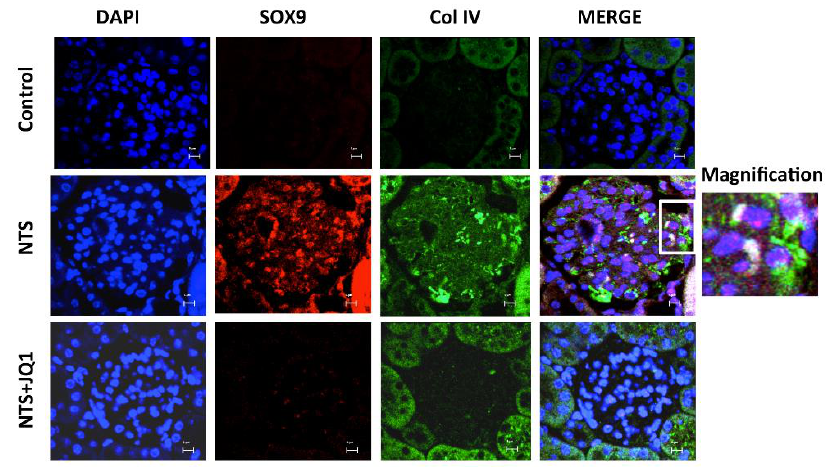
Figure 8. JQ1 treatment inhibits the expression and nuclear localization of SOX9 and the expression of type IV collagen in murine immune glomerulonephritis. Dual immunofluorescence staining for SOX9 and COLIV with two different fluorescent secondary antibodies, Alexa 568 and Alexa 488, respectively, disclosed nuclear translocation of SOX9 in NTS-induced glomerulonephritis, which colocalized with COLIV staining, and both were inhibited by JQ1. Scale bar represents 5 μM.